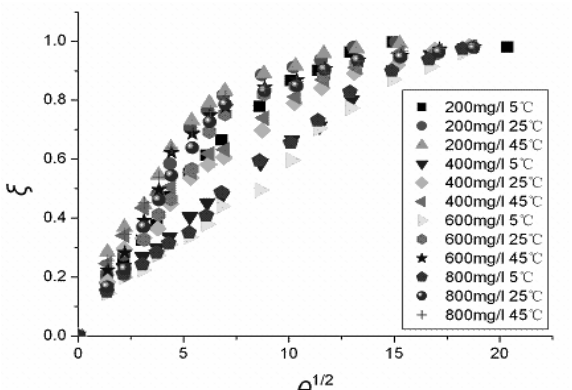
Figure 3. Plot of ξ vs. θ 1/2 in internal diffusion model. concentration refers to the initial acid red 3B